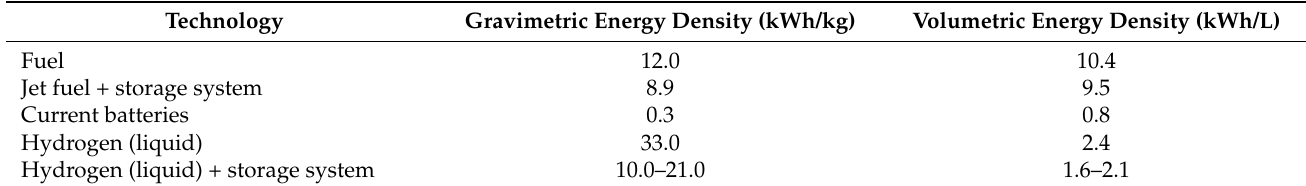
Table 7. Comparison of energy carriers and storage solutions in terms of gravimetric and volumetric energy